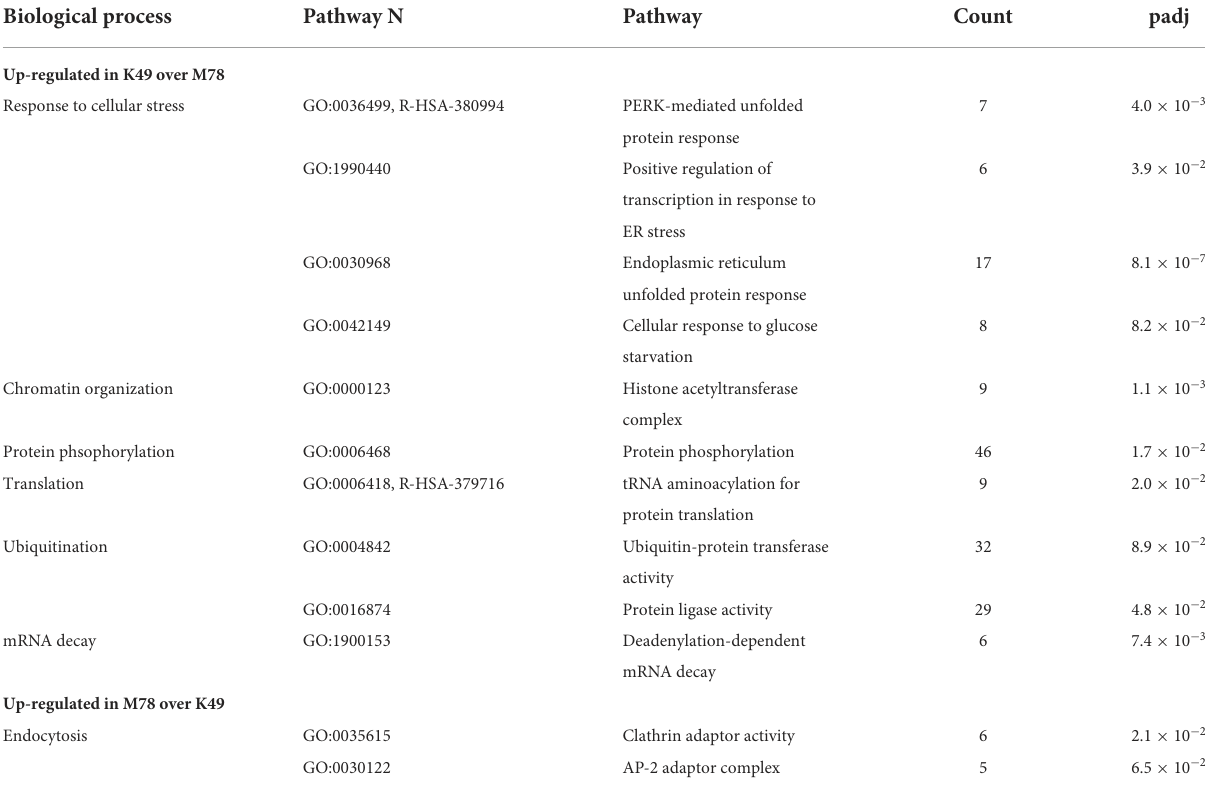
TABLE 3 Biological pathways with differently expressed genes in PBMCs infected with strain K49 compared to infected with strain M78 (FDR ≤ 0.05). Biological